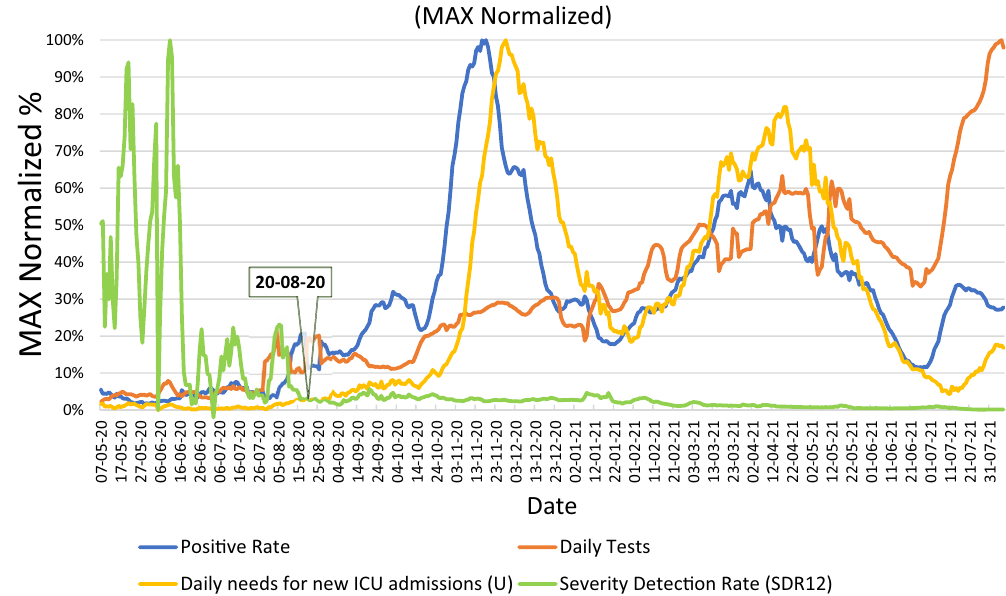
Figure 1. Comparison of trendlines of Severity Detection Rate, Daily needs for new ICU admissions, Positivity rate, and number of Daily Tests, in the period from 7/5/2020 to 8/8/2021. The Daily needs for new ICU admissions and the number of Daily Tests represent rolling 7-day averages. Severity Detection Rates and Positivity Rates were calculated from the rolling 7-day averages of their components. All numbers were normalized by their maximum value in the examined